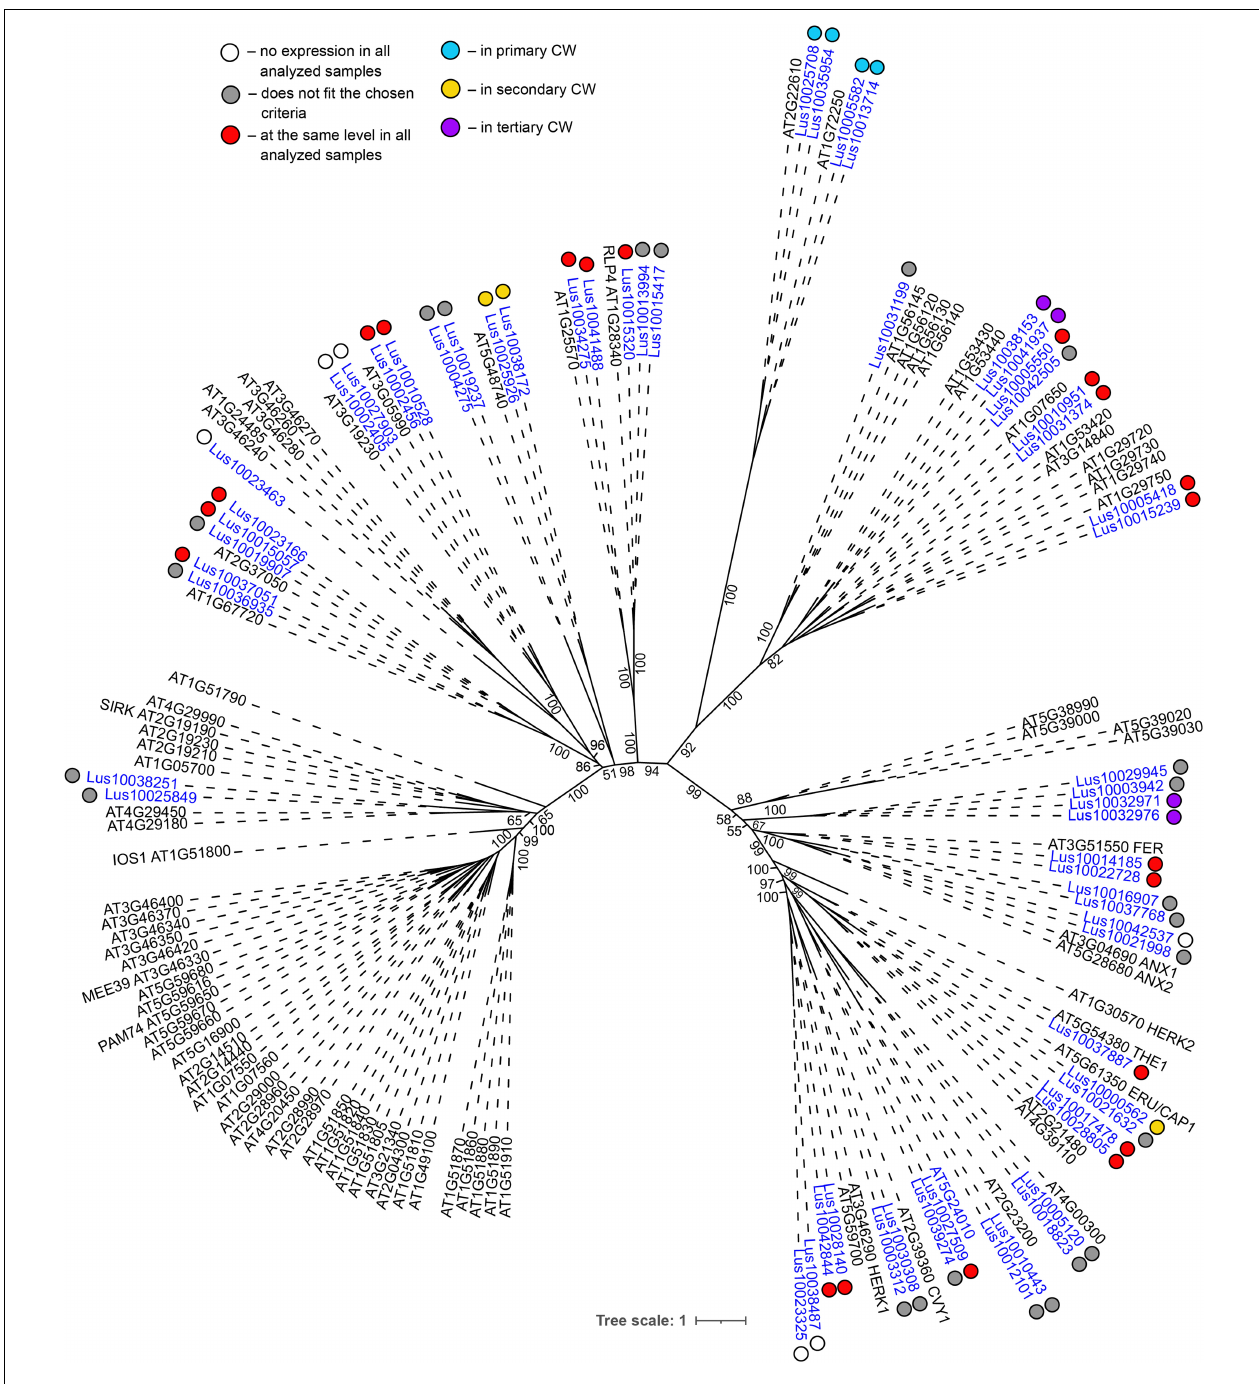
FIGURE 3 | Phylogenetic dendrogram of malectin (PF11721) and malectin–like (PF12819) family members of Arabidopsis thaliana and Linum usitatissimum . The A. thaliana gene names are given in black font; additional gene names are given according to descriptions in the Uniprot database (https://www.uniprot.org/; The UniProt Consortium, 2019). The L. usitatissimum gene names are given in dark blue font. The different colored dots next to L. usitatissimum gene names indicate genes with different expression patterns. The criteria used for different expression pattern identification as follow: red, the mean values of tau-score < 0.15 across all samples; light blue, DEGs upregulated in samples with primary CW; yellow, DEGs upregulated in samples with secondary CW; purple dots, DEGs upregulated in samples with tertiary CW. Flax genes with red, light blue, yellow, and purple dots are listed in Tables 2–5 , respectively. White dots indicate genes that are not expressed in the analyzed flax samples, and gray dots indicate genes where the expression does not fit the chosen criteria for a certain expression pattern (expression values for these genes are given in Supplementary File 3 ). Numbers indicate the ultrafast bootstrap support values for some branches. Abbreviations: DEGs, differentially expressed genes, a pairwise comparison log 2 FC ≥ 1; padj ≥ 0.01, CW, cell wall.